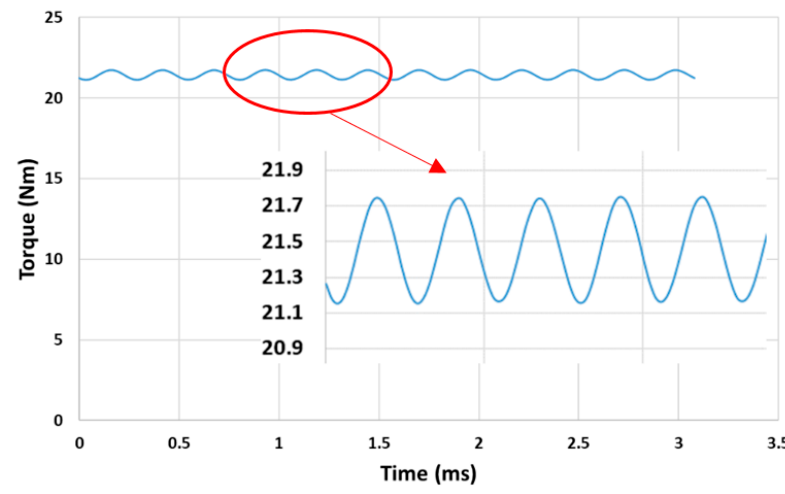
Figure 28. Torque and the torque ripple.